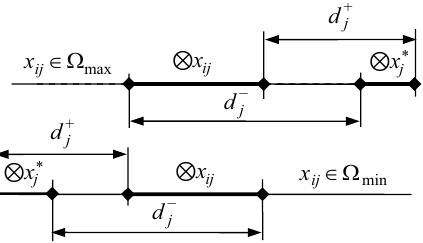
Fig. 5 . Characteristic reference point approaches